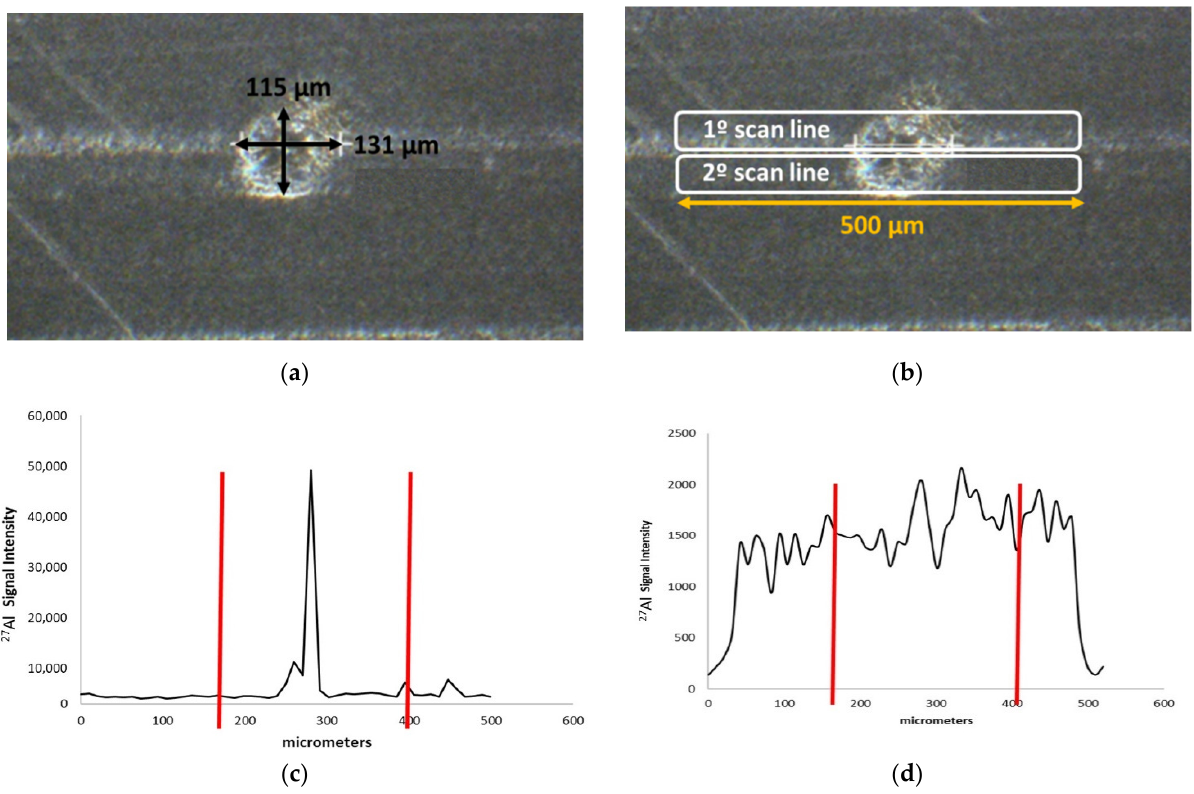
Figure 1. Dimensions of defect # 2 found on film # 1 ( a ); laser scan lines ( b ); 27 Al signal variation versus laser position for the first ( c ) and ( d ) second scan line, red vertical lines show the limits of the inclusion.